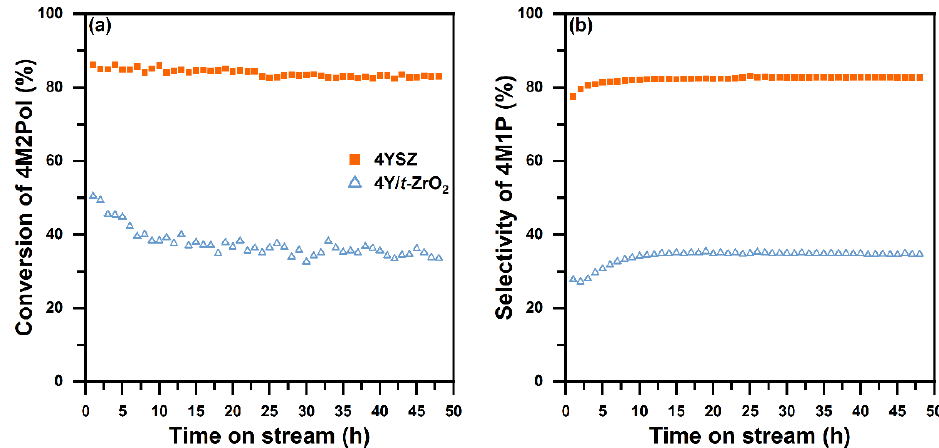
Figure 4. Long-term activity test at 450 °C for 50 h over 4YSZ and 4Y/ t -ZrO 2 . ( a ) Conversion of 4M2Pol. ( b ) Selectivity of 4M1P.